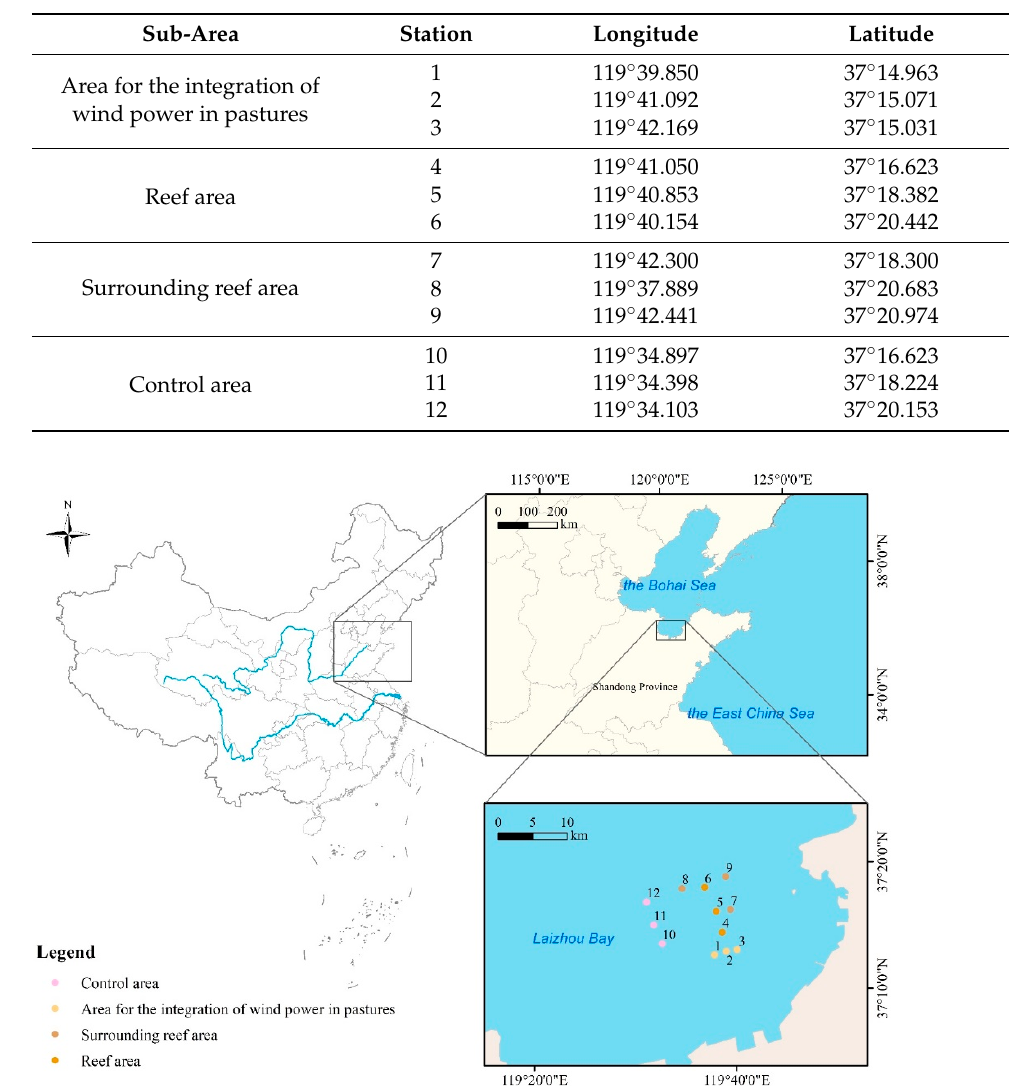
Figure 1. Station distribution map (the right side shows the specific distribution of stations in Laizhou Bay).